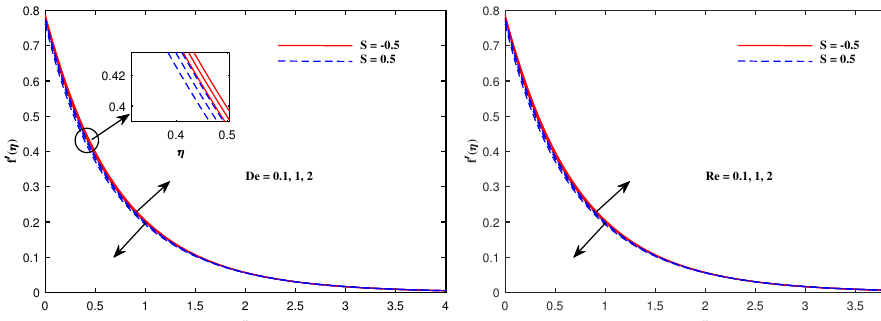
Figure 4. Velocity variation with De and Re .